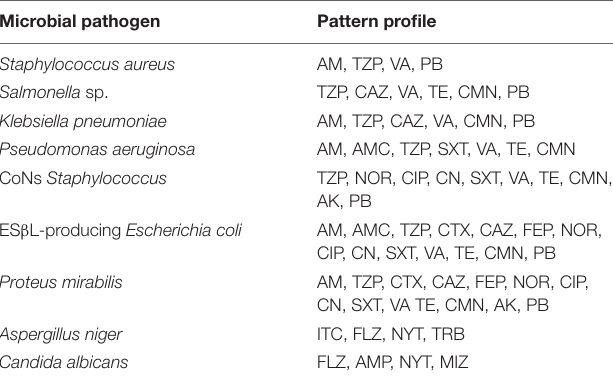
TABLE 1 | Antibiotic resistance patterns among bacterial and fungal pathogens used in this study. Microbial